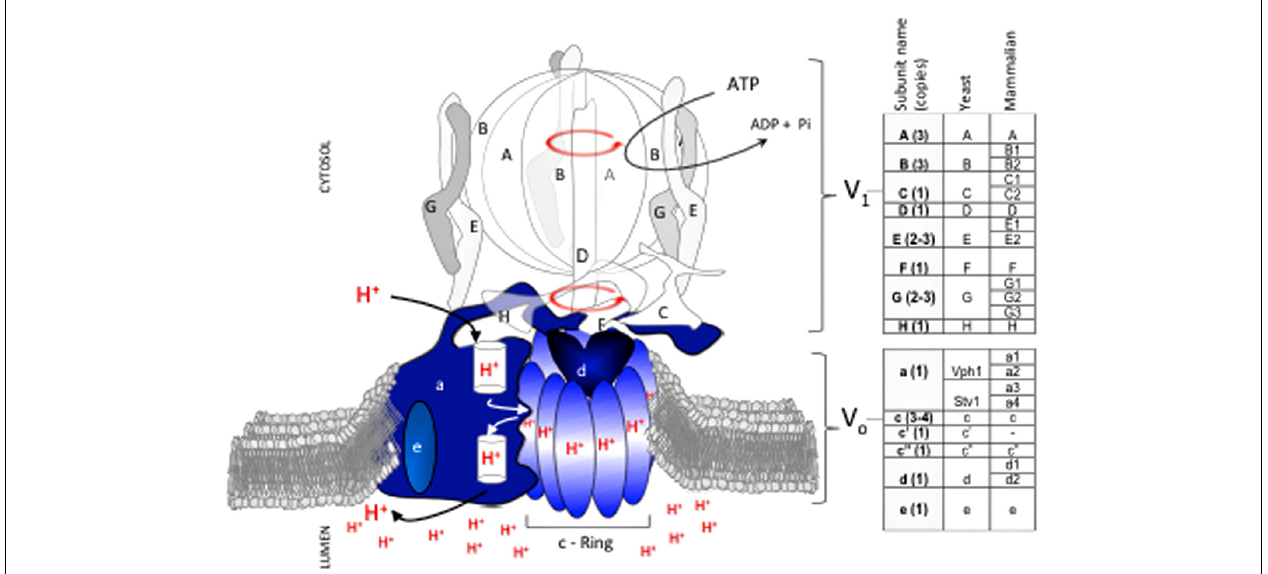
FIGURE 1 |V-ATPase subunit composition and mechanism of catalysis. TheV-ATPase proton pump acidifies the lumen of organelles in the endomembrane system of all eukaryotic cells.V-ATPase has 14 subunits that form two domains,V 1 andV o .V 1 (clear and gray subunits, A 3 B 3 CDE 3 FG 3 H) hydrolyzes ATP at the cytosolic side of the membrane, andV o (blue subunits, ac 3 − 4 c’c”de) translocates protons.Transport of protons against a concentration gradient entails a rotational mechanism. Hydrolysis of 3 ATP in